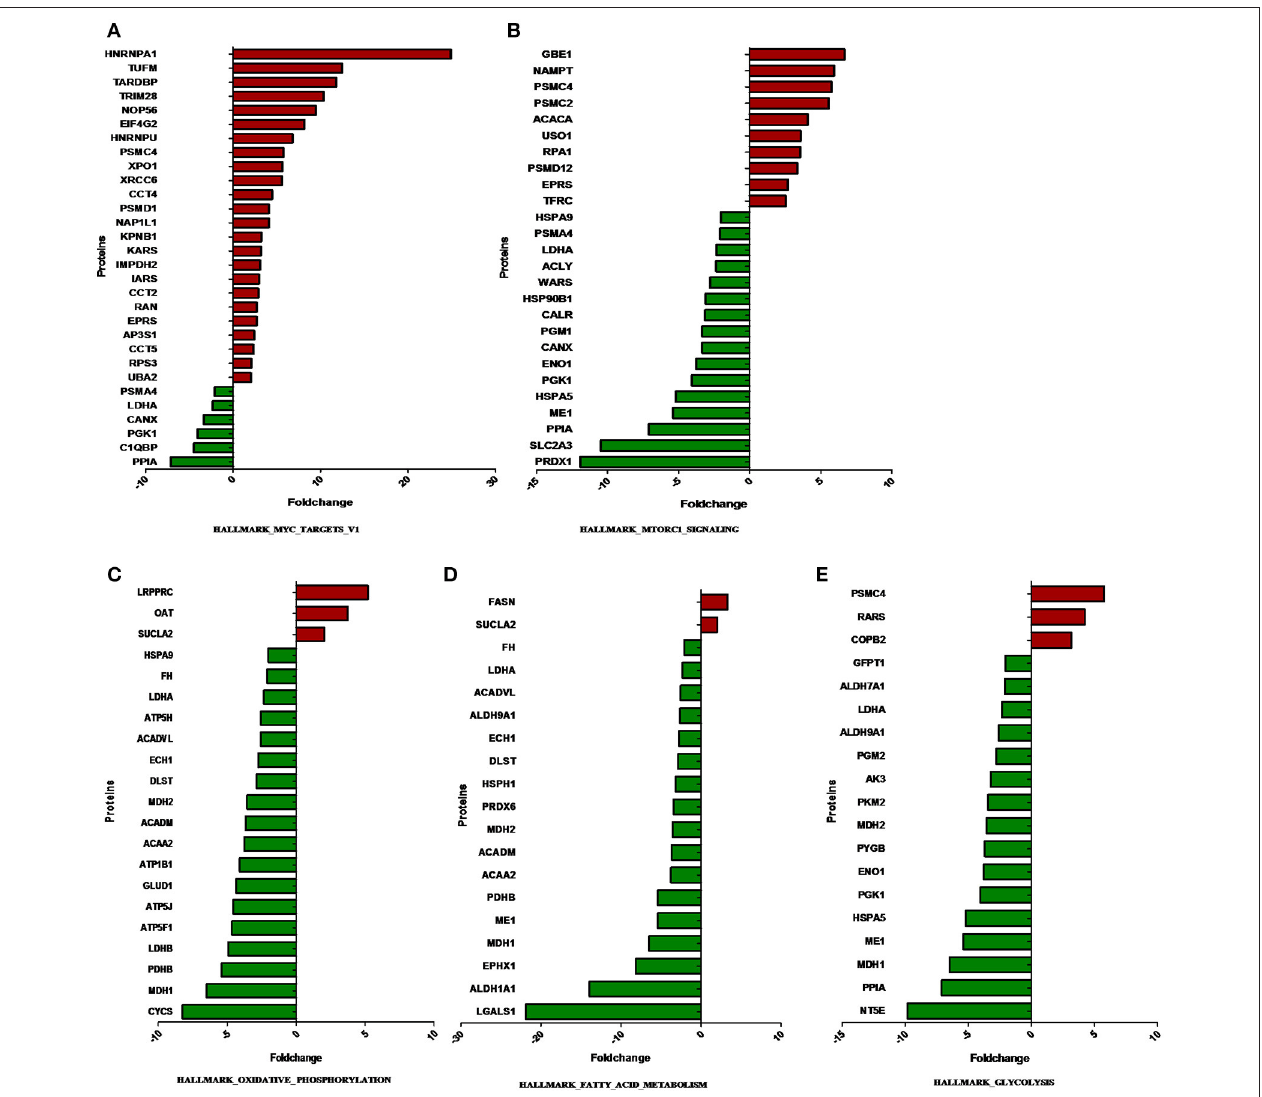
FIGURE 4 | The expression of proteins in metabolism-related hallmark pathways. The proteins differentially expressed between ACTH-PAs and normal pituitary glands are displayed along the X-axis. The Y-axis displays the –log of the p -value. (A) Proteins in HALLMARK_MYC_TARGETS_V1, (B) Proteins in HALLMARK_MTORC1_SIGNALING, (C) Proteins in HALLMARK_OXIDATIVE_PHOSPHORYLATION, (D) Proteins in HALLMARK_FATTY_ACID_METABOLISM, (E) Proteins in